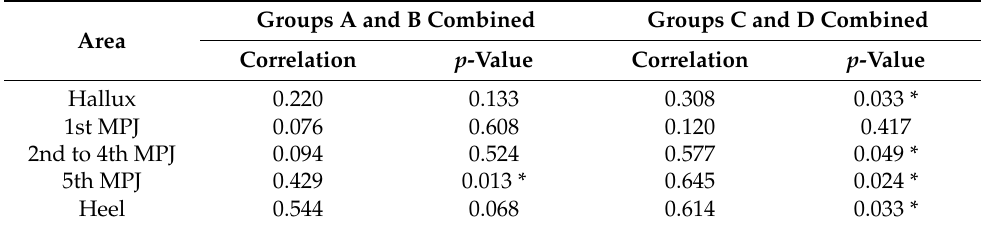
Table 2. Pearson correlation test of Groups A and B vs. Groups C and D. Groups A and B Combined Groups C and D Combined Area Correlation p -Value Correlation p -Value Hallux 0.220